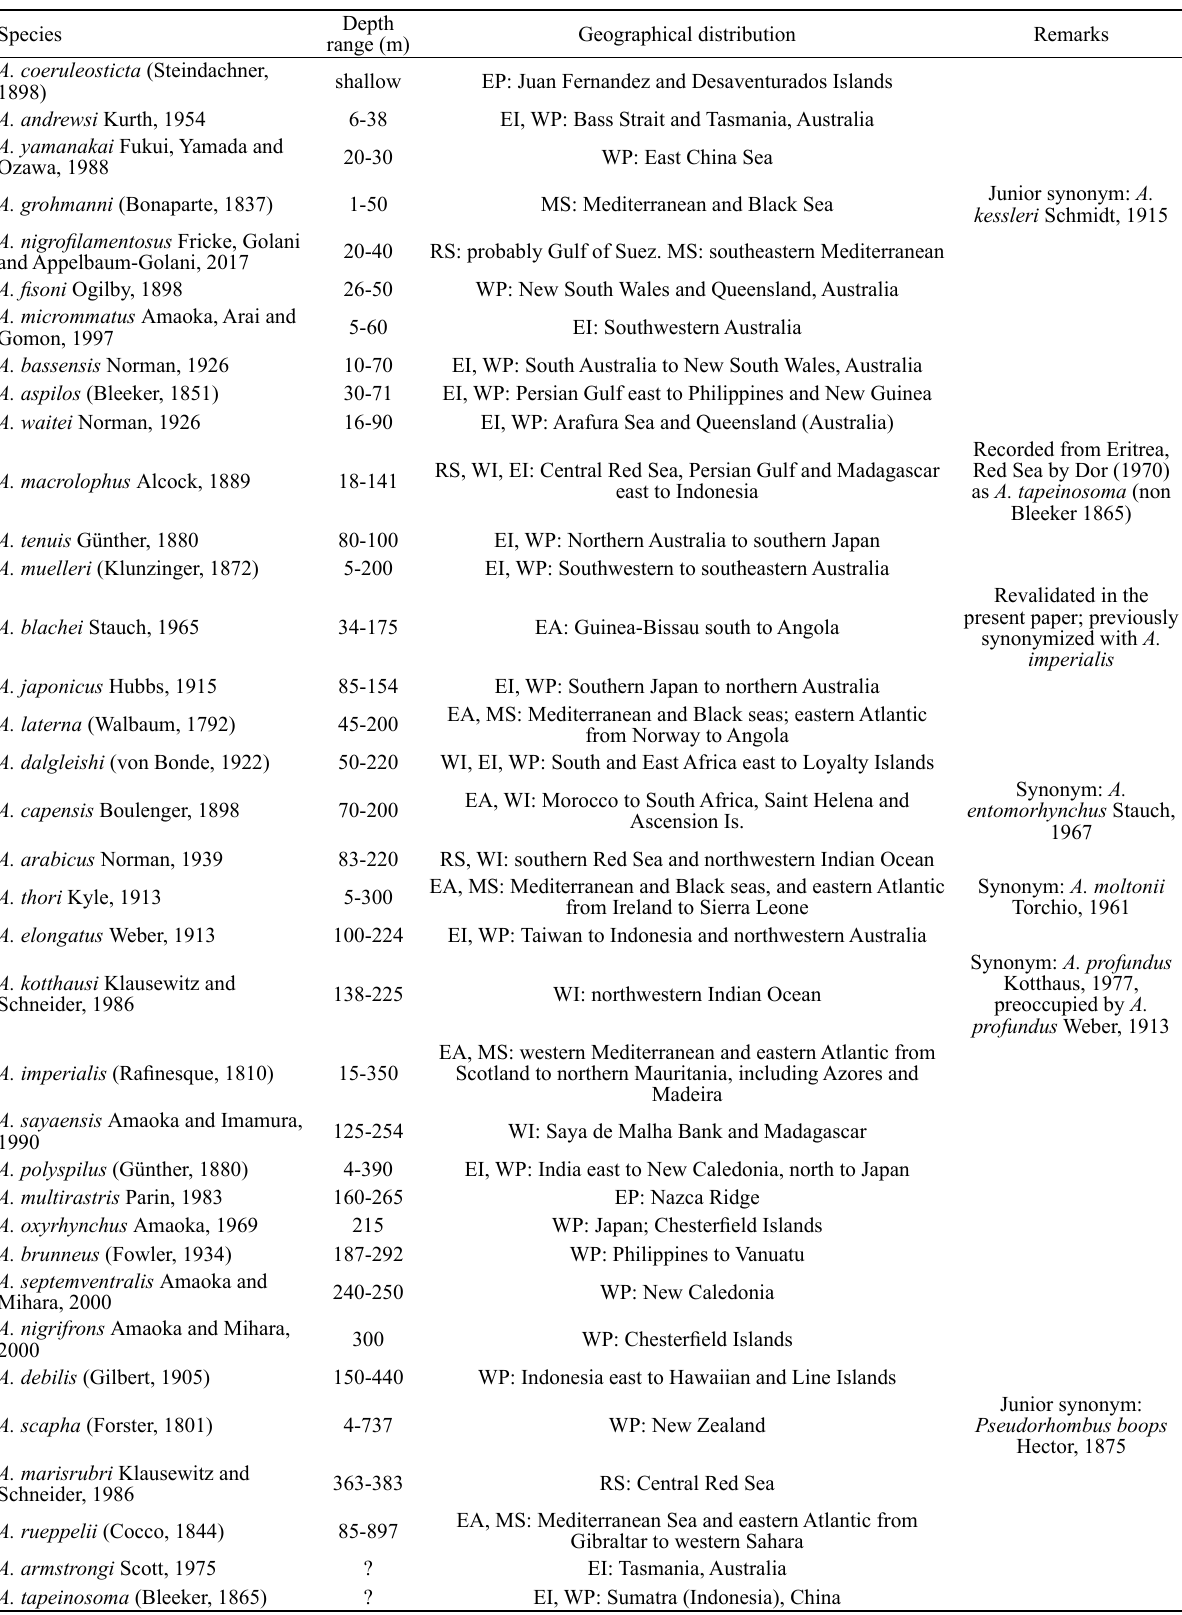
Table 1. – Valid species in the genus Arnoglossus Bleeker, 1862 and their distribution, arranged according to their mean depth distribution. EA, eastern Atlantic; EI, eastern Indian Ocean; EP, eastern Pacific; MS, Mediterranean Sea; RS, Red Sea; WA, western Atlantic; WI, western Indian Ocean; WP, western